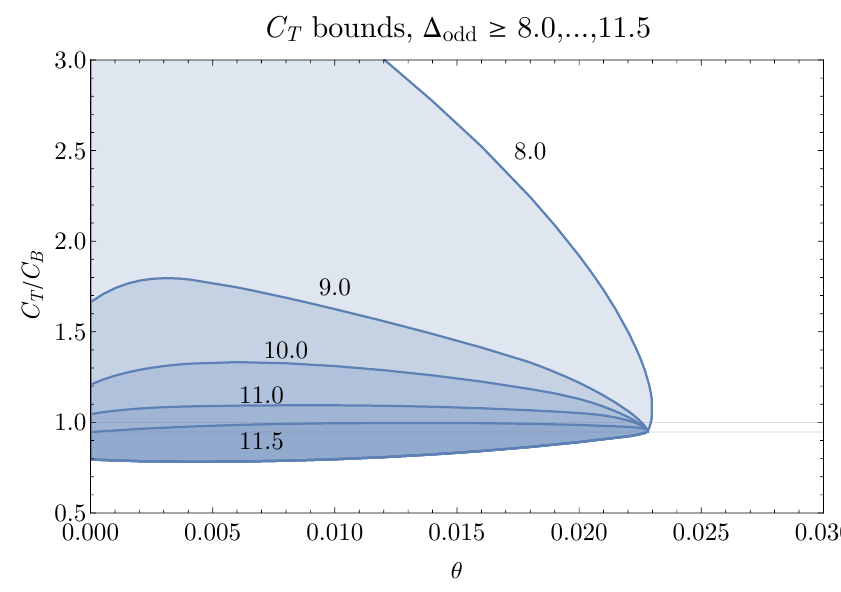
Figure 6 . Closed regions for ( (cid:18); C T ), given various large gaps in the parity-odd scalar sector. The lower horizontal line shows the value of C T in the 3d Ising